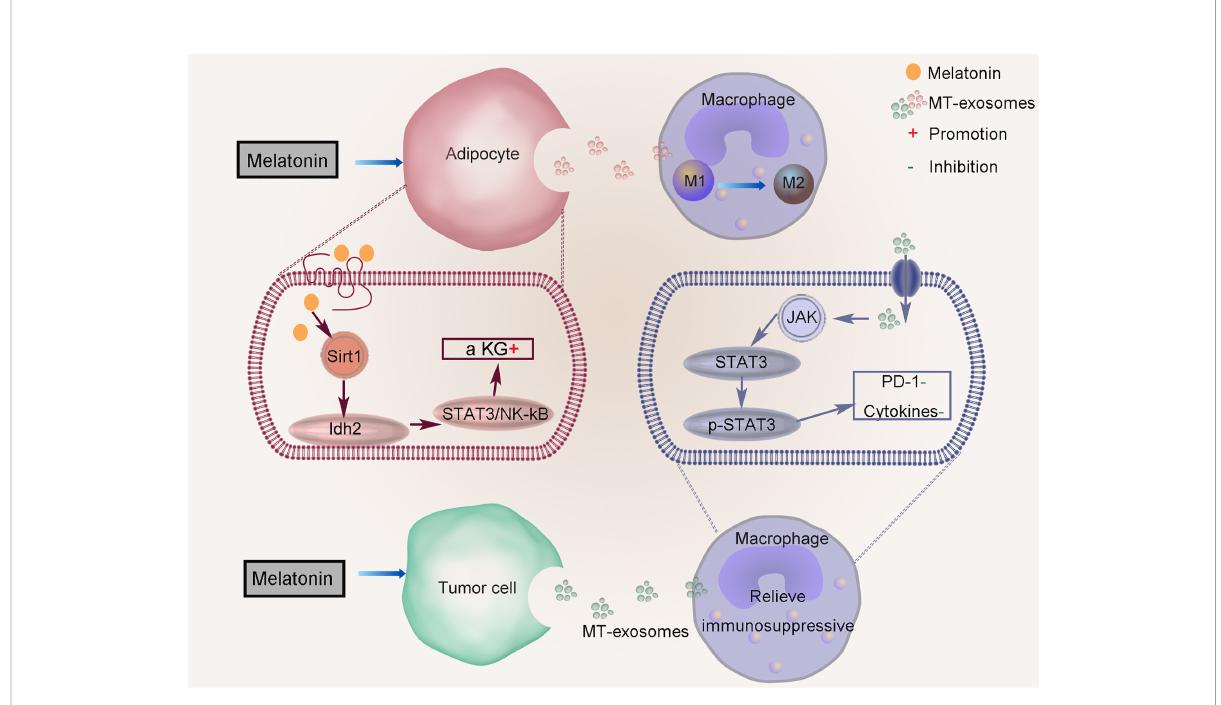
FIGURE 4 Regulation of anti-in fl ammatory effect of MT-exosomes. Melatonin mediates the in fl ammatory response by increasing a -ketoglutarate ( a KG) level and transferring to macrophages through exosomes in adipose tissue. MT-exosomes from HCC cells reverse this effect by down- regulating the expression of PD-1 and altering the secretion of macrophage cytokines through inactivating the STAT3 signaling